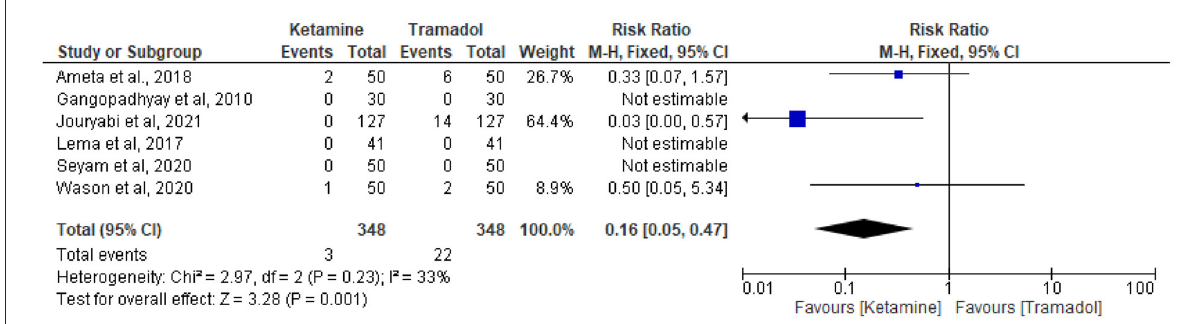
FIGURE8 The effect of tramadol vs. ketamine on the incidence of bradycardia.